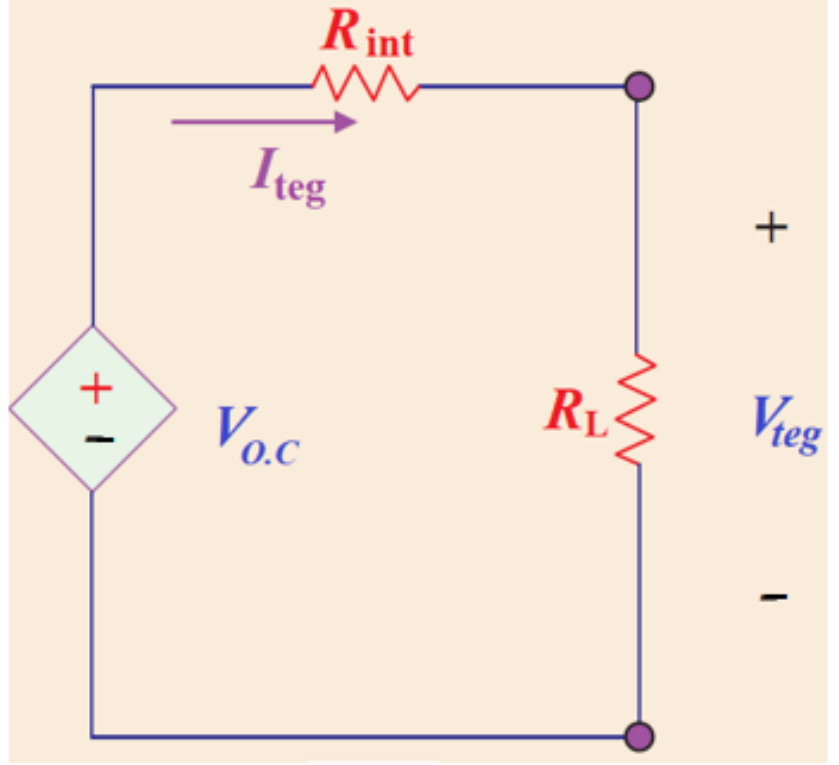
Figure 4. The sample circuit of the TEG component.